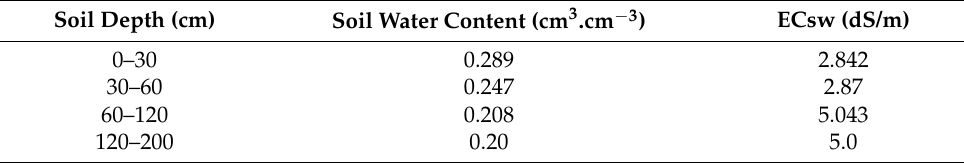
Figure 1. Time series of daily crop evapotranspiration and precipitation (15 May 2016 to 31 December 2016). Table 3. The initial soil water content and soil